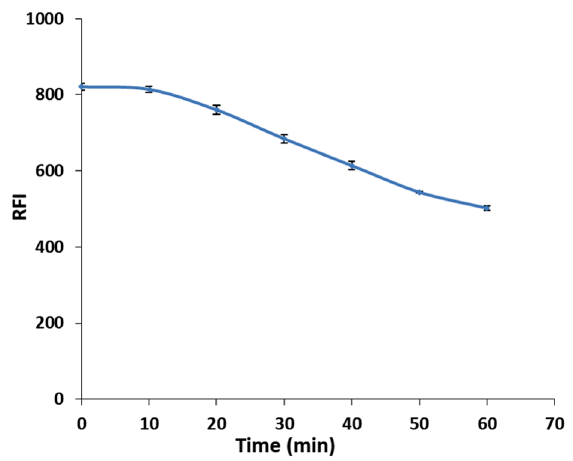
O on the RFI 2 2